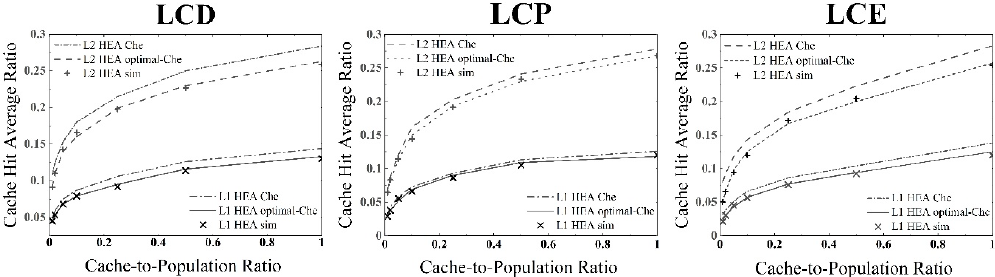
Figure 6. Hit ratio vs cache size for various caching strategies in di ff erent approximation approaches.